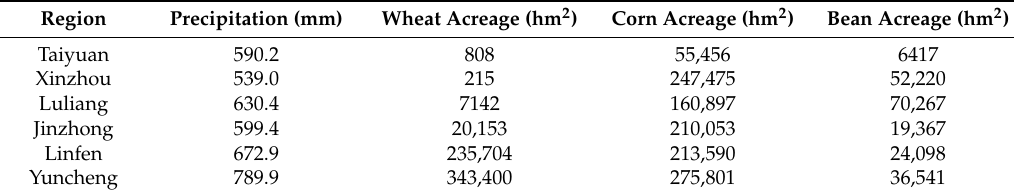
Table 5. Regional water resources and crop structure in 2012.